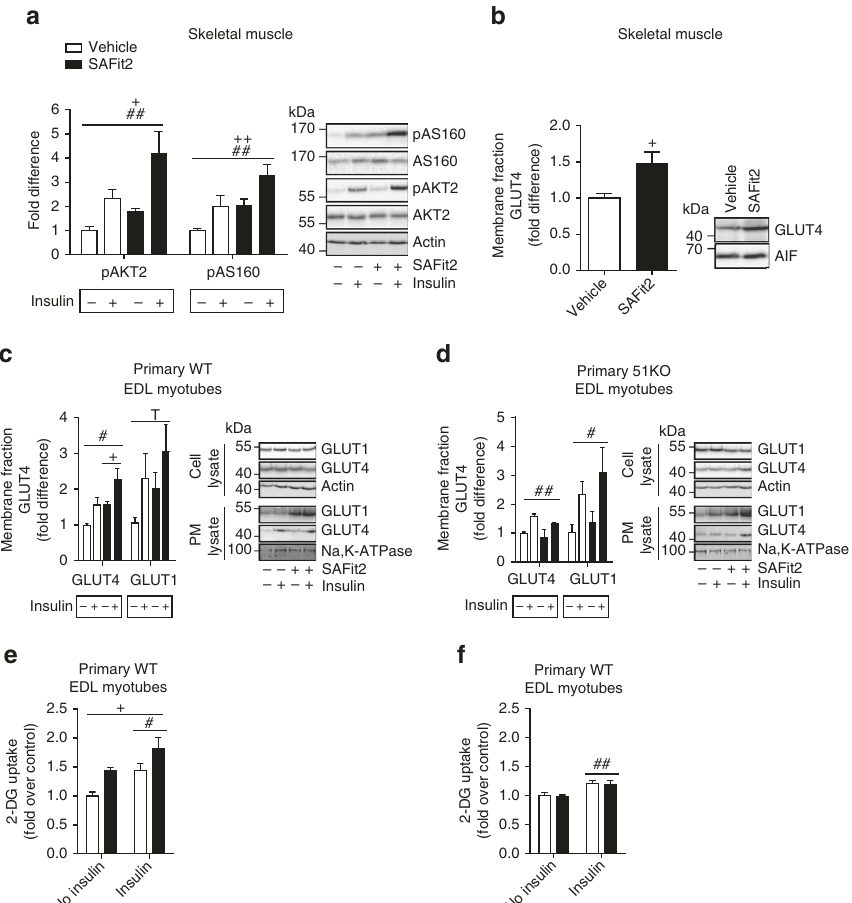
Fig. 5 FKBP51 antagonism affects insulin signaling and consequently glucose uptake. a The insulin signaling pathway was enhanced in EDL skeletal muscle of mice treated with SAFit2 compared to vehicle-treated mice, independent of insulin, as assessed by pAKT2, and pAS160 protein expression. b GLUT4 expression at the membrane was increased 6 h following SAFit2 treatment in soleus skeletal muscle. c GLUT4 expression at the membrane was increased from SAFit2 treatment in primary EDL myotubes from WT mice, whereas GLUT1 expression was unchanged by SAFit2 treatment. d SAFit2 had no effect on GLUT4 plasma membrane expression in primary EDL muscle cells collected from 51KO mice. e FKBP51 antagonism with SAFit2 increased 2-deoxyglucose uptake in primary EDL muscle cells collected from WT mice independent of insulin condition. f SAFit2 had no effect on 2-deoxyglucose uptake in primary 51KO muscle cells. For quanti fi cation of phosphorylated protein expression in mice, n = 6 per group. For quanti fi cation of GLUT4 expression in mice, n = 7 per treatment. For GLUT1/4 expression in primary EDL myotubes, n = 3 per group. For glucose uptake experiments, 3 wells for each condition were measured. Data are expressed as relative fold change compared to vehicle condition ± SEM. + P < 0.05, ++ P < 0.01, # P < 0.05, ## P < 0.01, two-way ANOVA for a – f ; + signi fi cant treatment effect, # signi fi cant insulin effect, T trend ( p < 0.1) for insulin effect. Supplementary Figs. 13 and 14 show